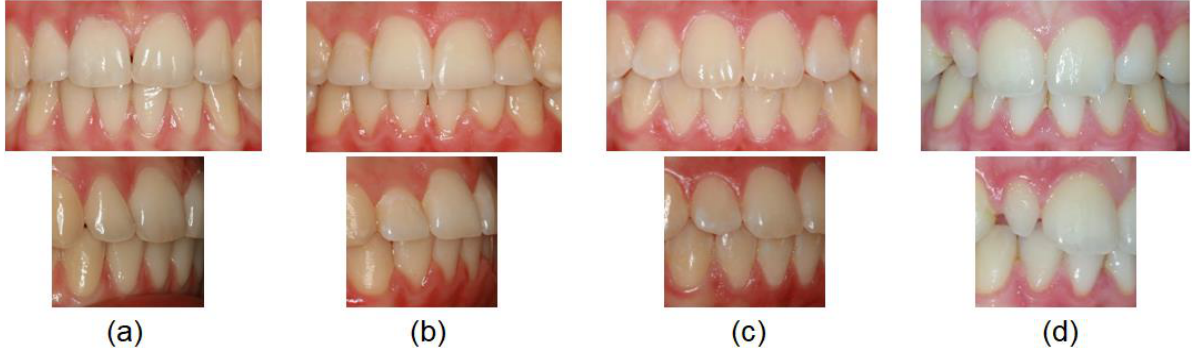
Figure 1. Various crown morphology evaluated as: ( a ) trapezoidal-shaped, ( b ) central incisor-shaped, ( c ) canine-shaped and ( d ) peg-shaped.